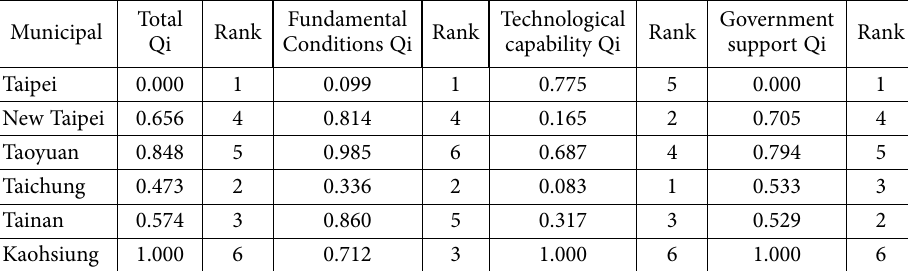
Table 5. Innovation and technology capabilities for the six metropolitan areas-Total 36